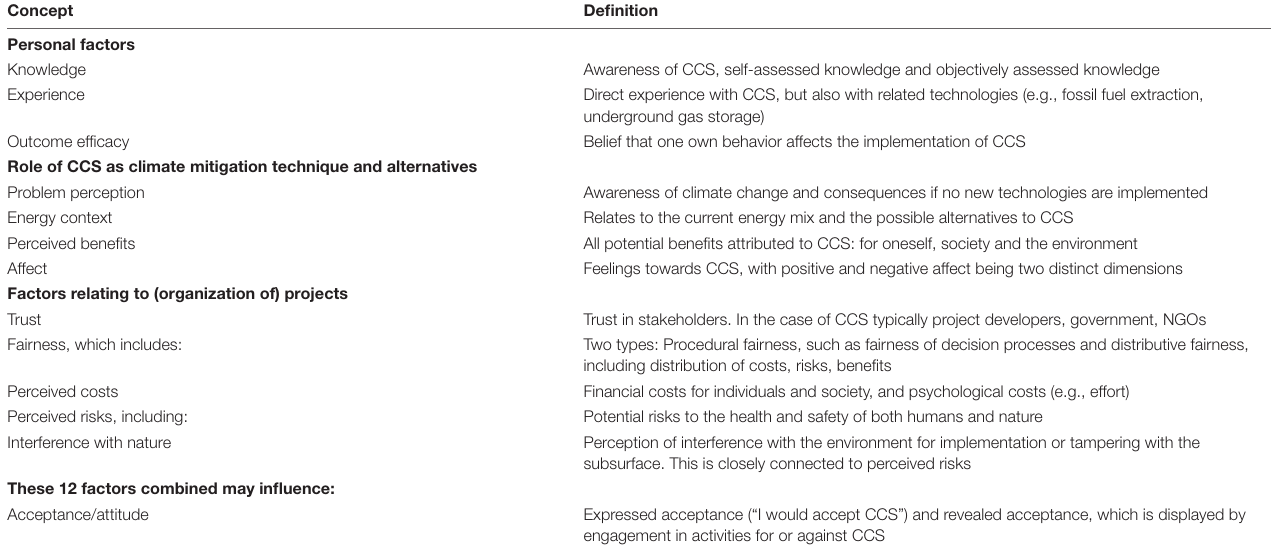
TABLE 5 | Overview of CCS technology acceptance